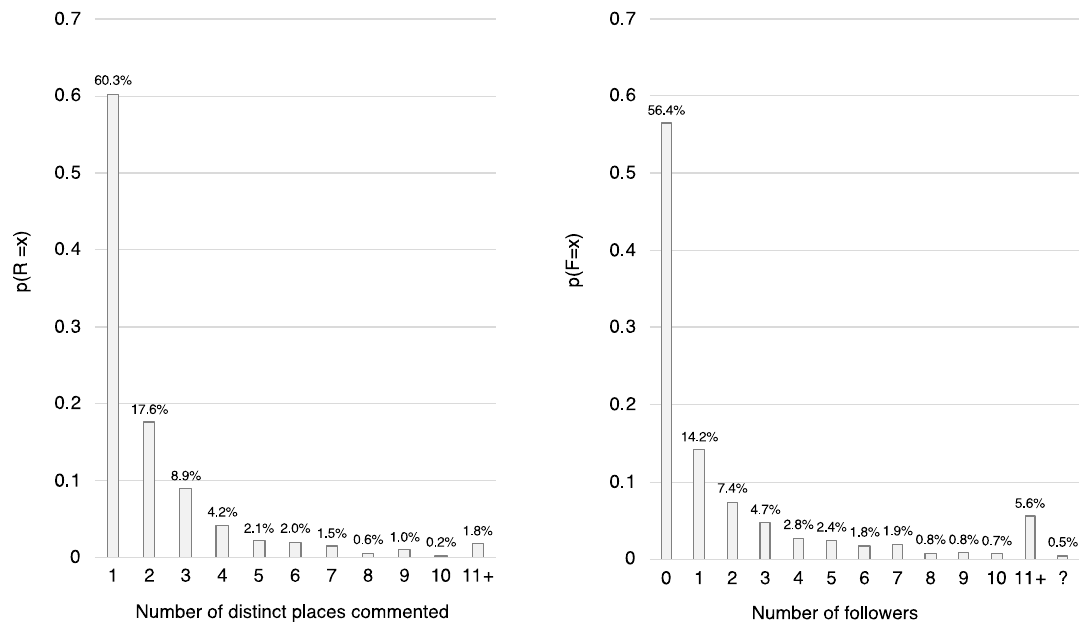
Figure 6. The left side indicates the sampled distribution of the number of distinct places about which users posted a review, R. The right side shows the sampled distribution of the variable F, the number of followers a user has on the social medium Qyer. Most users (60%) only commented on one place in Switzerland. Also, the majority of observed users (56%) have no followers. ( n = 2984).